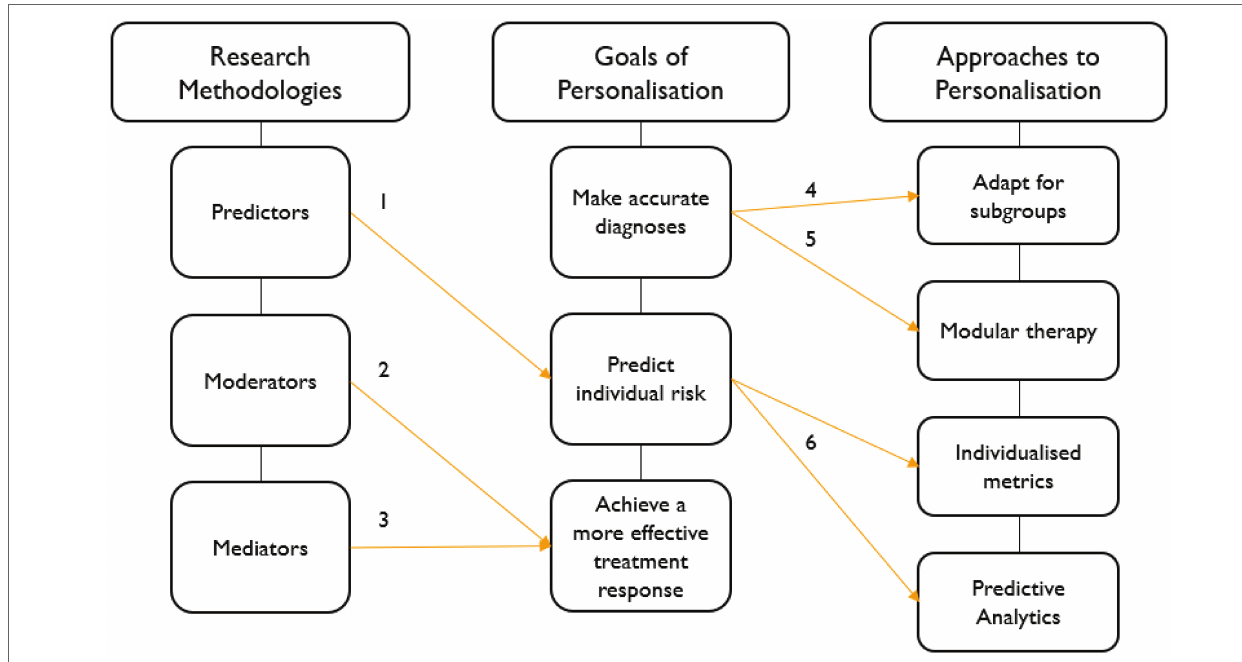
FIGURE 1 | Conceptual Model of Personalised CBT for Childhood Anxiety. 1. Predictors predict risk of optimal/non-optimal response (i.e., parental psychopathology); 2. moderators predict benefit of one treatment over another for a subgroup of children (i.e., CBT over SRT for children with generalised anxiety disorder (GAD)); 3. mediators highlight mechanisms of change that influence outcome (i.e., reduce negative self-talk and increase coping abilities); 4 & 5. accurate diagnosis may facilitate subgroup and modular approaches (i.e., could children with SoAD benefit from additional social skills training or could anxious youth with comorbid depression benefit more from additional mood management modules?); and 6. understanding factors that predict individual risk facilitates the use of metrics and predictive analytics to inform treatment decisions (personalisation) to improve treatment